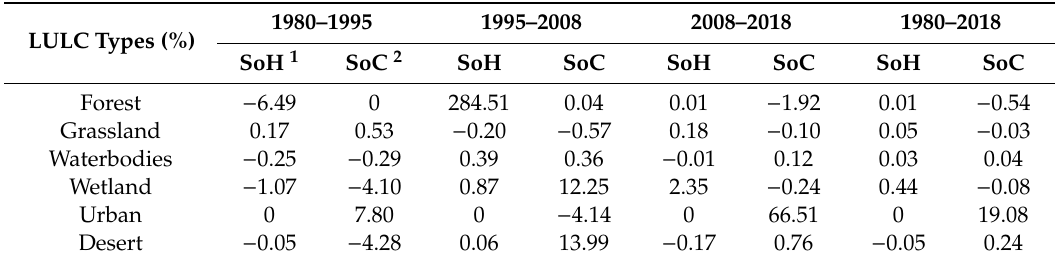
Table 3. Land use dynamics in the study area during 1980–2018 and for di ff erent periods before and after the establishment of the